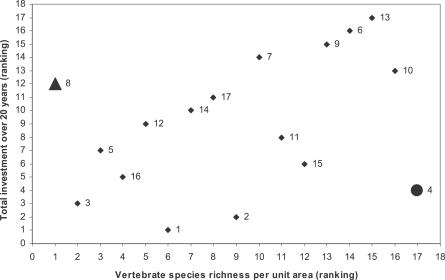
Scatter Plot of the Ecoregion Priorities When Ranked According to Total Investment and Vertebrate Species RichnessEcoregion codes are those provided in Figure 1, and vertebrate richness is represented by the richness of vertebrates per unit area (based on the total area of each ecoregion). Discrepancy between rankings is marked. The Chilean matorral ecoregion (denoted by a circle) has low species richness per unit area, but received a relatively large funding allocation over 20 y. The Jarrah-Karri forest and shrublands ecoregion (denoted by a triangle) has the greatest vertebrate species richness per unit area, but received a relatively small funding allocation over 20 y.